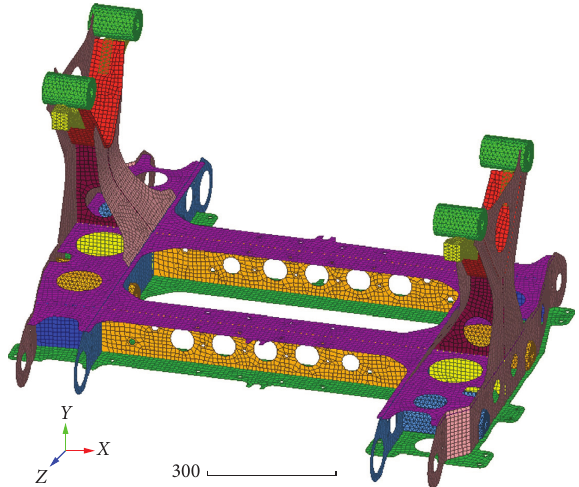
Figure 4: Finite element model of motor hanger.